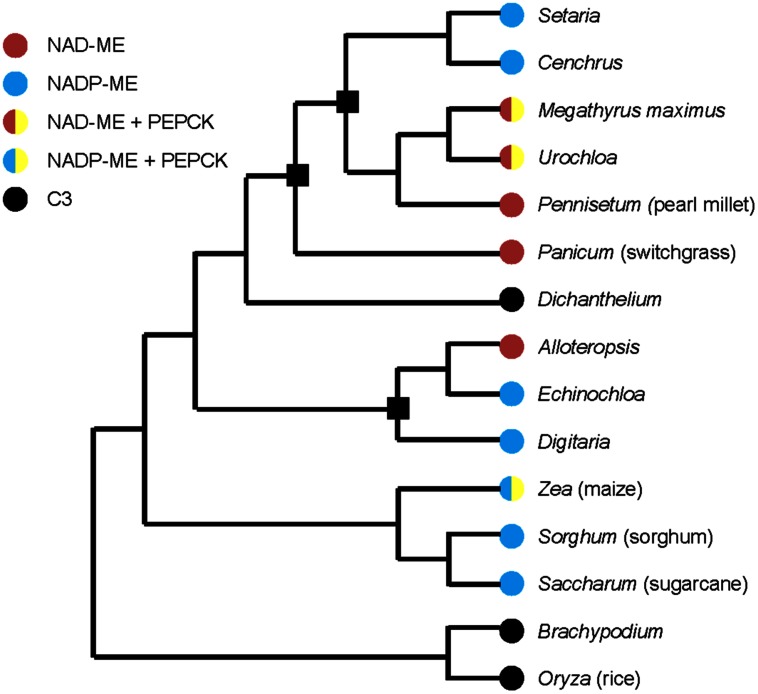
Simplified phylogenetic tree of grasses with selected C4 and C3 families, drawn based on Grass Phylogeny Working Group II (2012) and Washburn et al. (2015). Black square means the possible evolutionary conversions between NAD-ME and NADP-ME subtypes. Representative species of families are marked in parentheses.